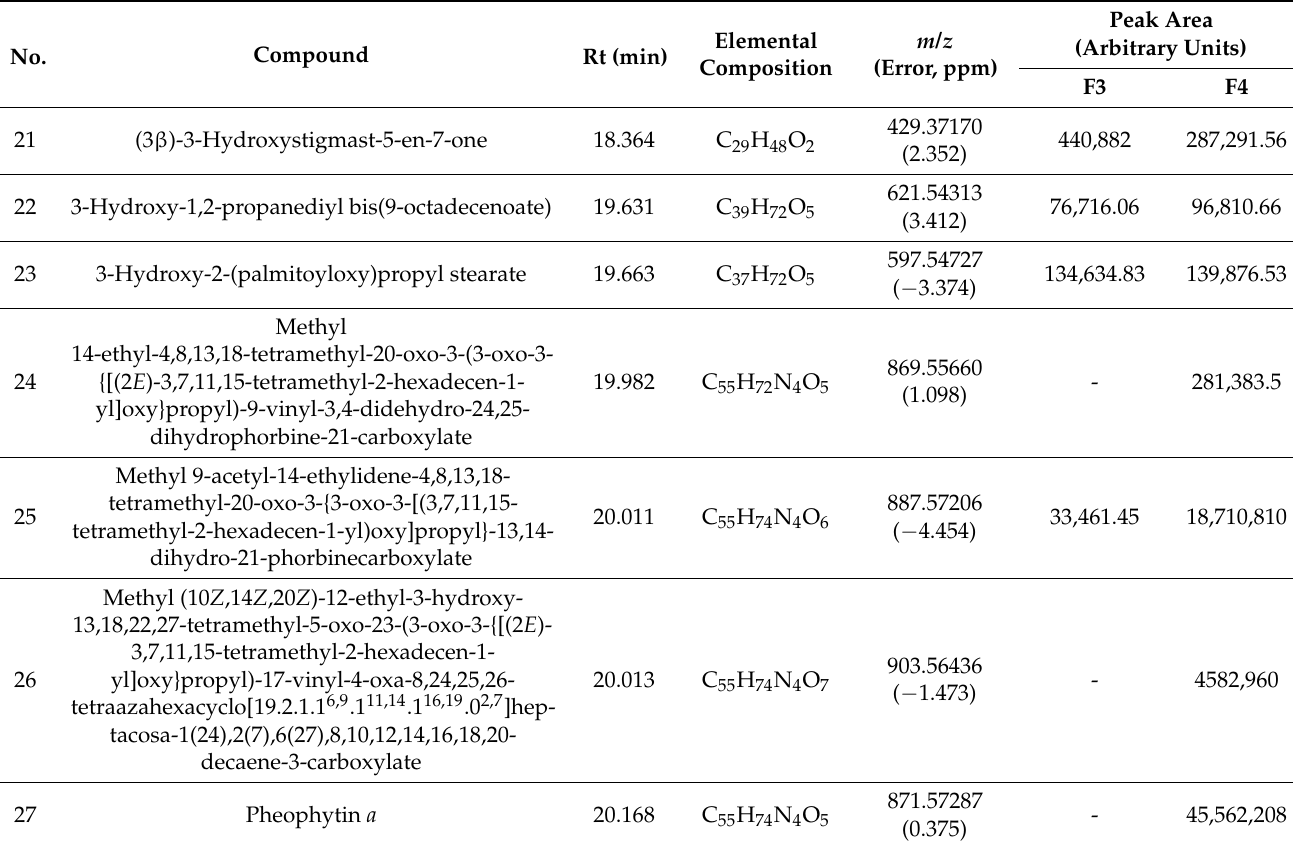
Figure 4. Extracted ion chromatograms (XIC) of most abundant ions in the fractions ( a ) F3 and ( b ) F4 (zoomed). Well-known green pigment chlorophyll was not detected in the fractions, but its de- rivatives devoid of magnesium atoms constituted the major compounds, particularly in F4 (Table 4). Identified chlorophyll derivatives can be divided into two sub-groups con-